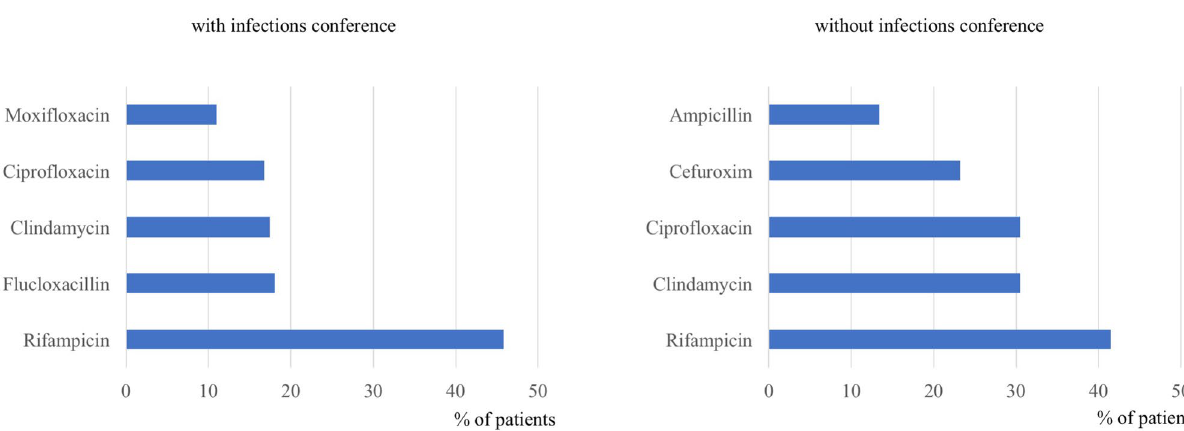
Figure 3. Relative distribution of top five oral antibiotics used in both groups. Number of patients included: 82 (without infections conference), 155 (with infections conference). With infections conference (n = 212) Without infections conference (n = 149) p -value Mean length of hospital stay 27 ± 21 31 ± 22 0.1 Mean length of ICU Table 5. Mean length and standard deviation of total hospital stay in days as well as mean length and standard deviation in days of intensive care unit treatment.